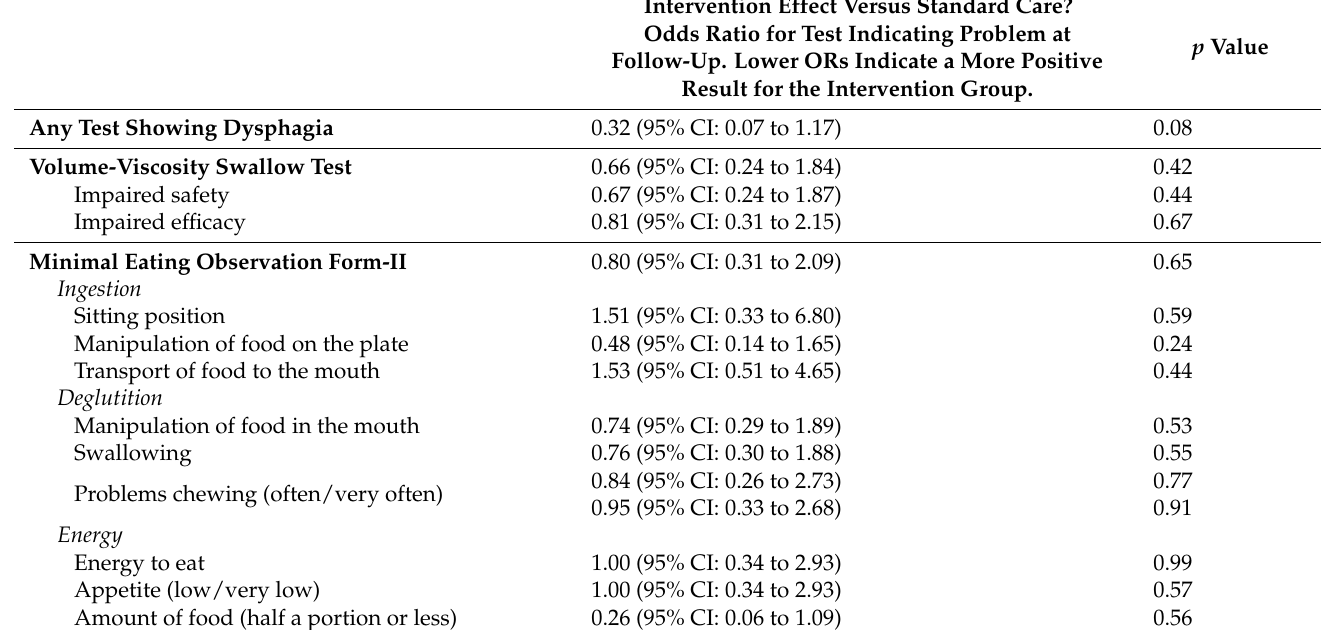
Table 2. Effect of intervention on overall frequency of dysphagia, V-VST and MEOF-II based on logistic regression with multiple imputation ( n = 92). Intervention Effect Versus Standard Care? Odds Ratio for Test Indicating Problem at Follow-Up. Lower ORs Indicate a More Positive Result for the Intervention